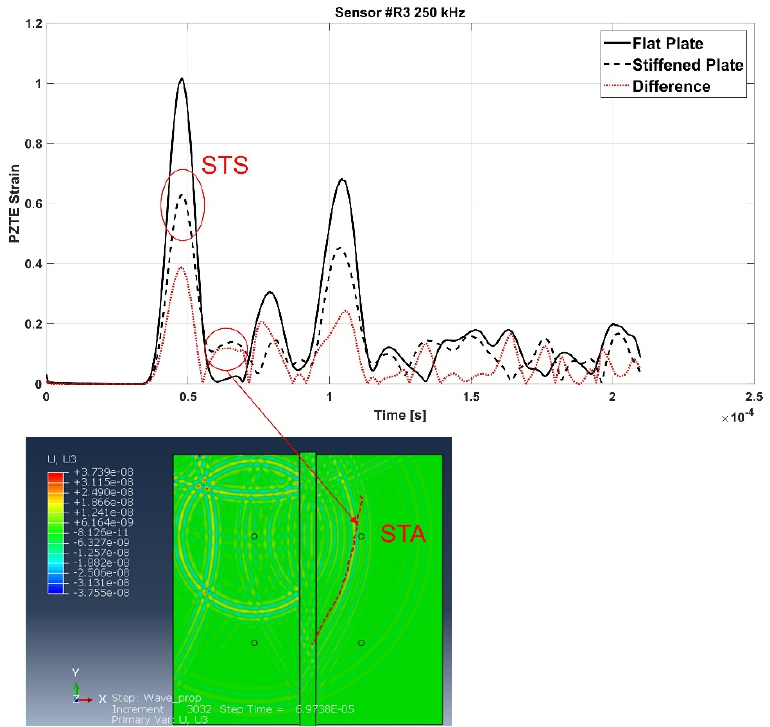
Figure 8. STA wave mode at 250 kHz carrier detected by the R2 sensor – aluminum stiffened plate.